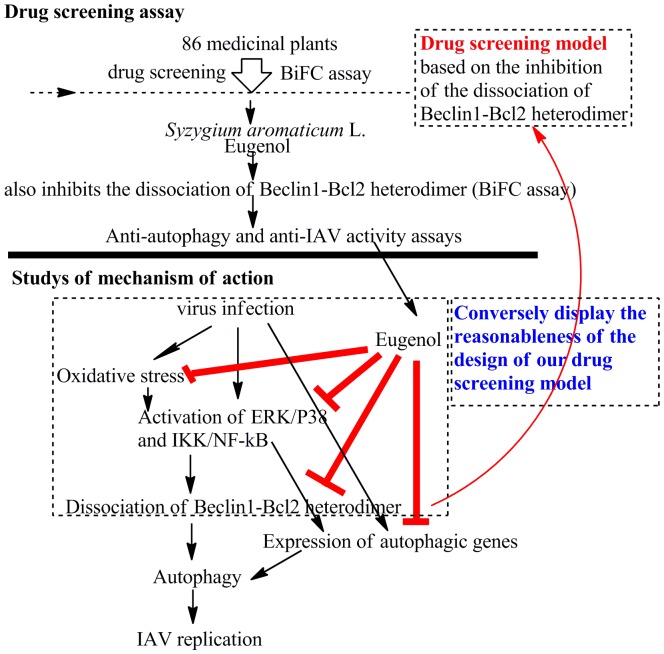
The design of our experiment and the mechanism of action of eugenol.Eighty six traditional Chinese medicines were screened by our drug screening model which was based on the inhibition of the dissociation of Beclin1-Bcl2 heterodimer, and Syzygium aromaticum L. was found to have the best activity. We purchased eugenol, the major active compound of Syzygium aromaticum L. and found it also inhibited the dissociation of Beclin1-Bcl2 heterodimer. We then detected the anti-autophagy and anti-IAV activity of eugenol. Next we explored the mechanism of action of eugenol. Eugenol could inhibit the oxidative stress and the activation of ERK/JNK/p38 MAPK and IKK/NF-κB pathways induced by IAV infection, both of them were important regulators of the dissociation of Beclin1-Bcl2 heterodimer, and thus conversely displayed the reasonableness of the design of our drug screening model. Moreover, eugenol also inhibited the expression of autophagic genes. Eventually, eugenol inhibited autophagy and impaired IAV replication.